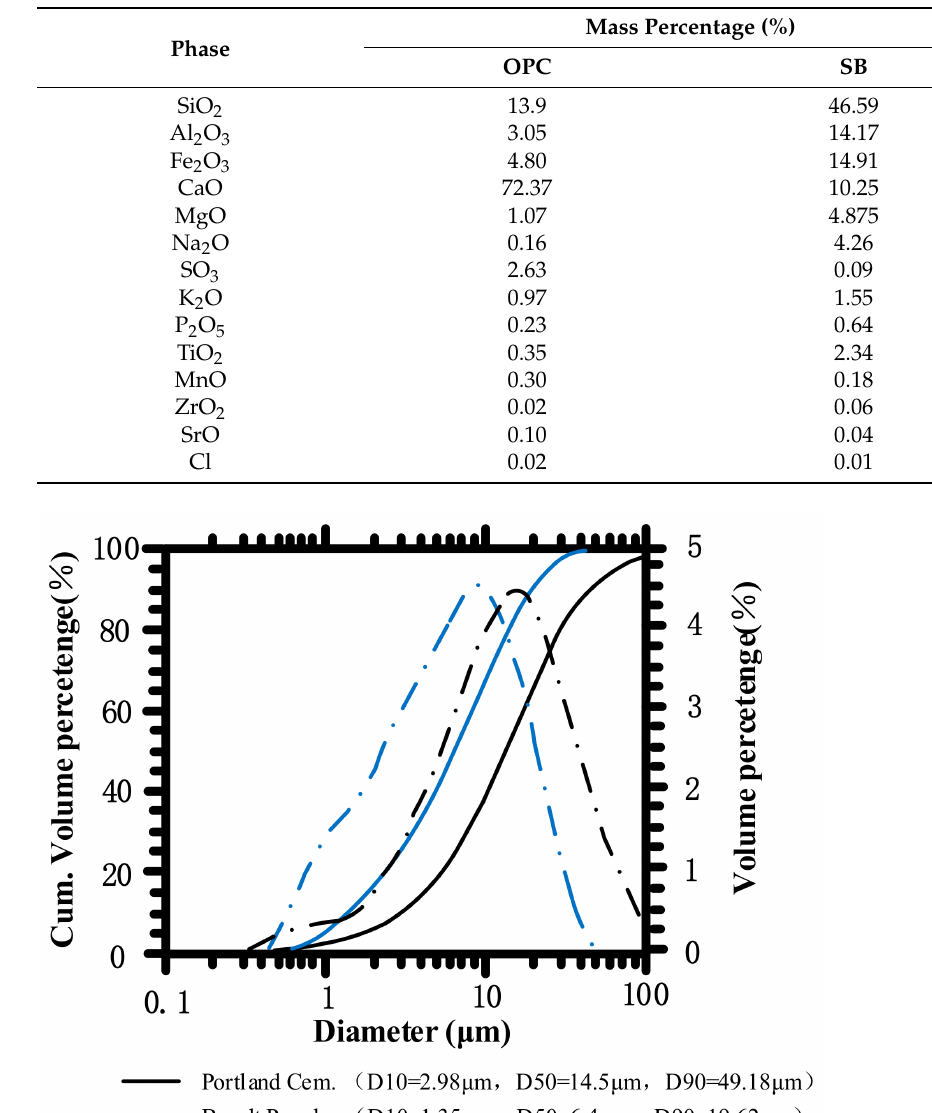
Table 1. Chemical compositions of OPC and SB used in the experiment.